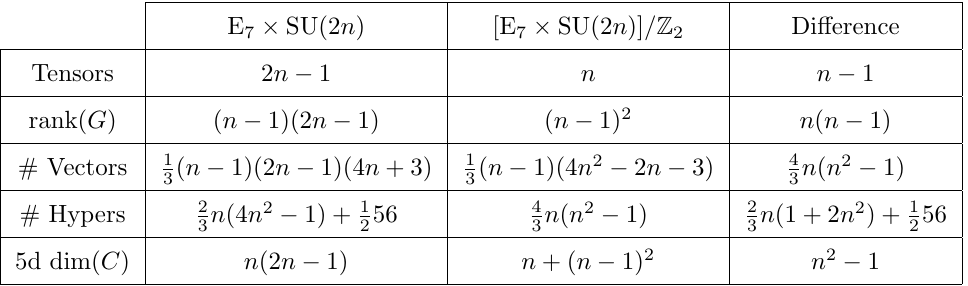
Table 4 . Comparison of the e 7 su 2 n SCM theories with and without torsion. G refers to the (cid:2) gauge algebras. In the last column we give the dimension of the Coulomb branch dim( C ) of the 5D circle reduced